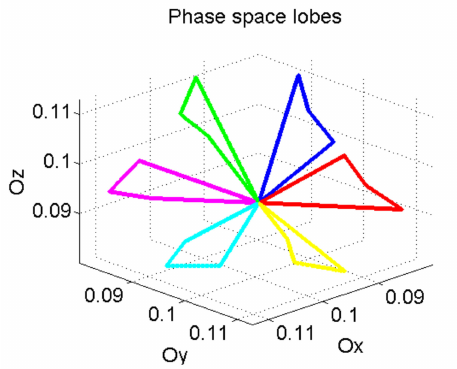
Figure 5. Phase space lobes generated from the set of 6 auxiliary signals used as IF laws for the signals defined in time domain.